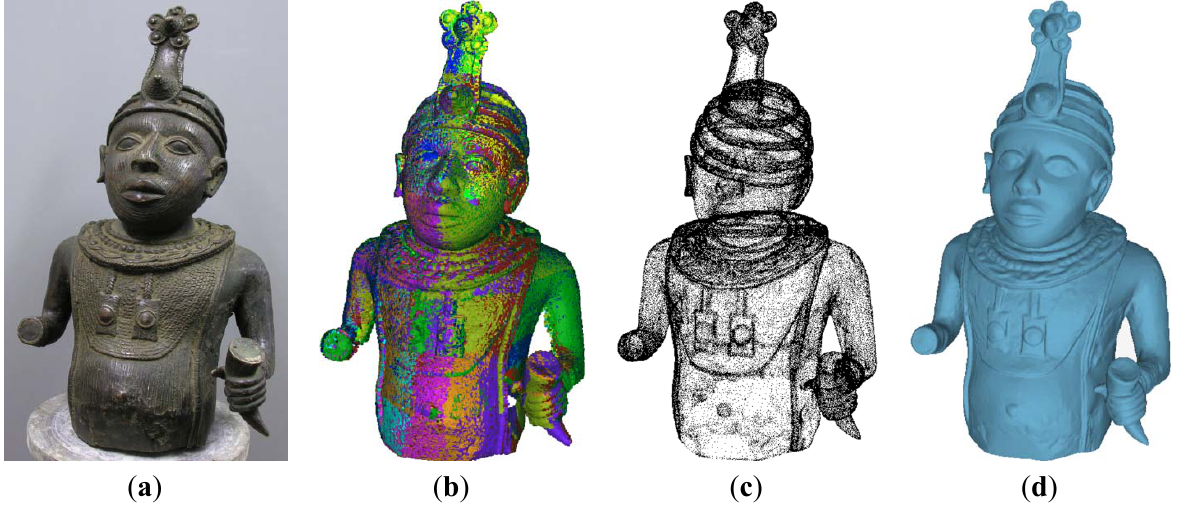
, T ) is tr-art tr-art